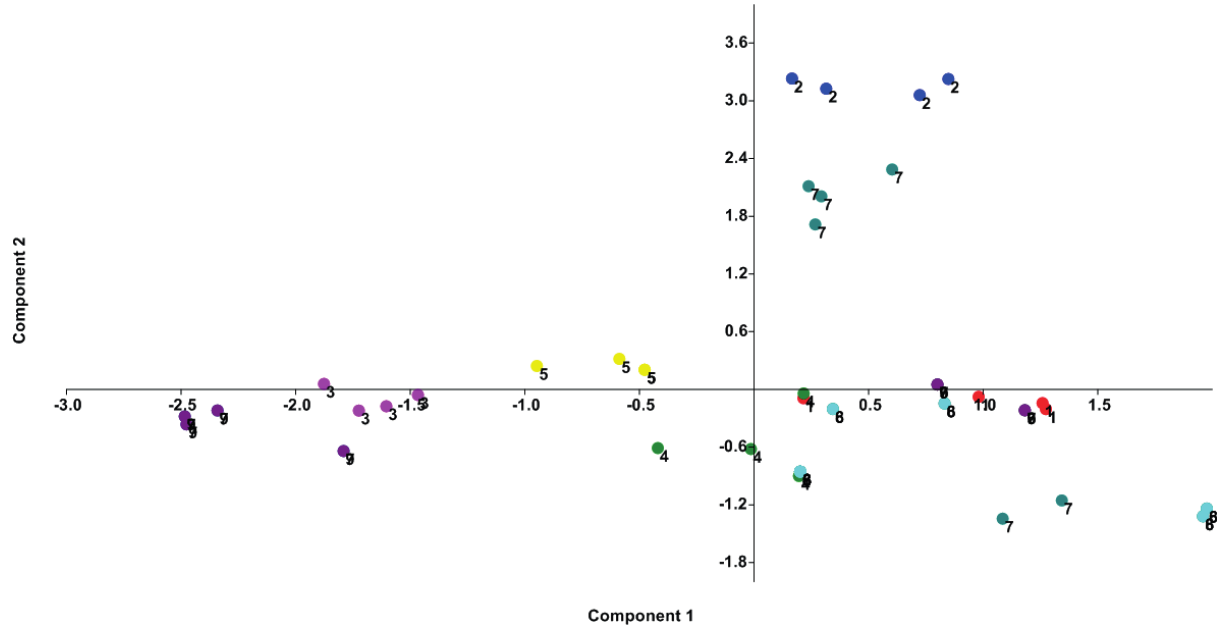
Figure 2. PCA plots of morphological characters revealing species delimitation in Alcea